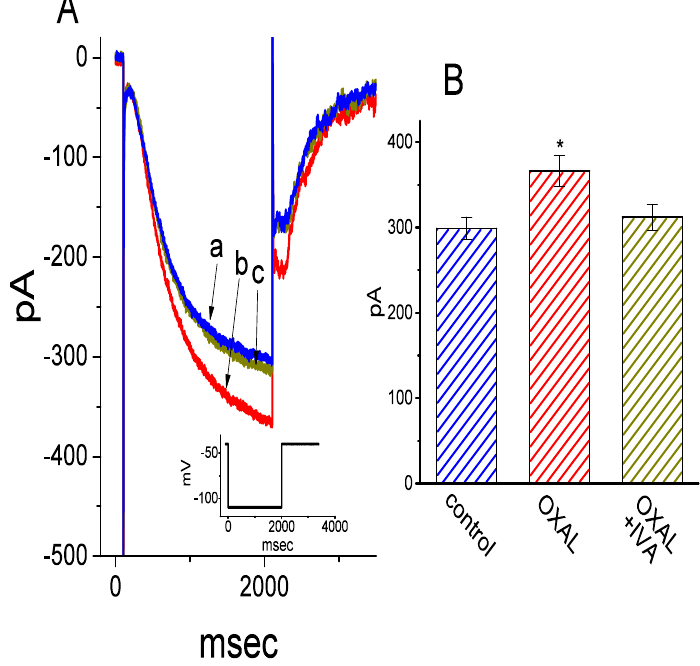
Figure 6. The stimulatory e ff ect of OXAL on I h in rat pituitary R1220 cells. Cells were immersed in Ca 2 + -free Tyrode’s solution and the examined cells were maintained at − 40 mV. ( A ) Representative I h traces elicited by a 2 s step hyperpolarization from − 40 to − 110 mV (as indicated in inset). a: control; b: 1 µ M OXAL; c: 1 µ M OXAL plus 3 µ M ivabradine. ( B ) Summary bar graph showing e ff ects of OXAL (1 Current amplitude was taken at the end of hyperpolarizing pulse from − 40 to − 110 mV. * Significantly di ff erent from control ( p <